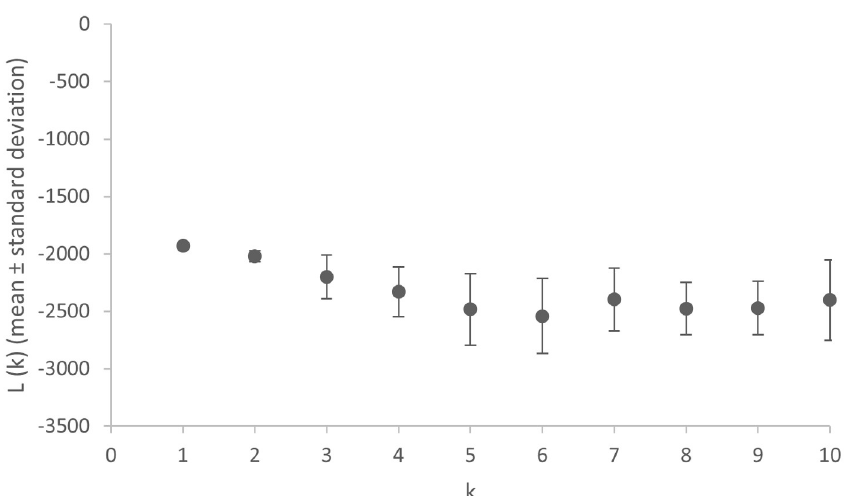
Fig 3. Plot of mean ln P(X|K) over 10 independent runs for each K (K = 1–10) suggests a higher likelihood of one cluster